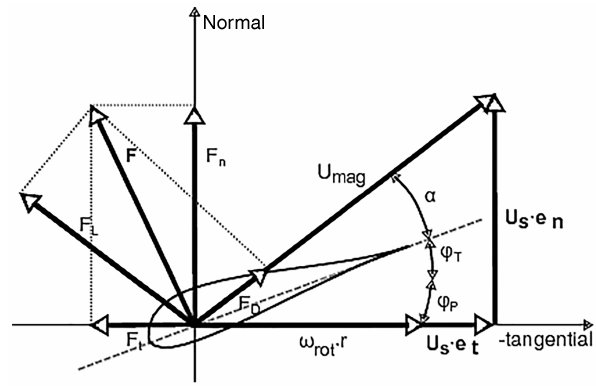
Figure 1. Geometry and forces in an airfoil section of the